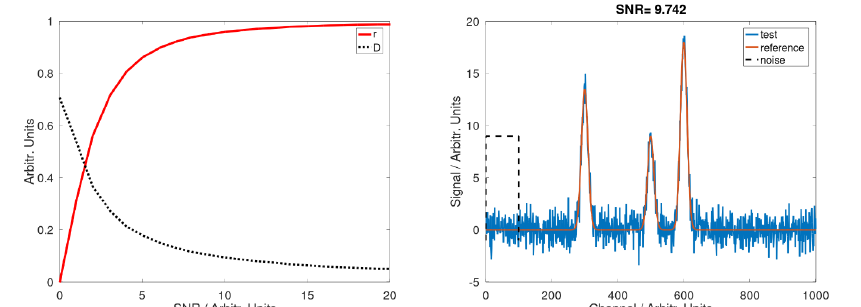
Figure 1. Left : Correlation coefficient (red) and Euclidean distance (black) between a reference spectrum and the same spectrum with added synthetic noise for different signal-to-noise amounts. Right : The reference spectrum (orange) and the same spectrum with added synthetic noise (blue) for the case SNR = 9.26. The black dashed box indicates the region where the noise is estimated as the standard deviation of the